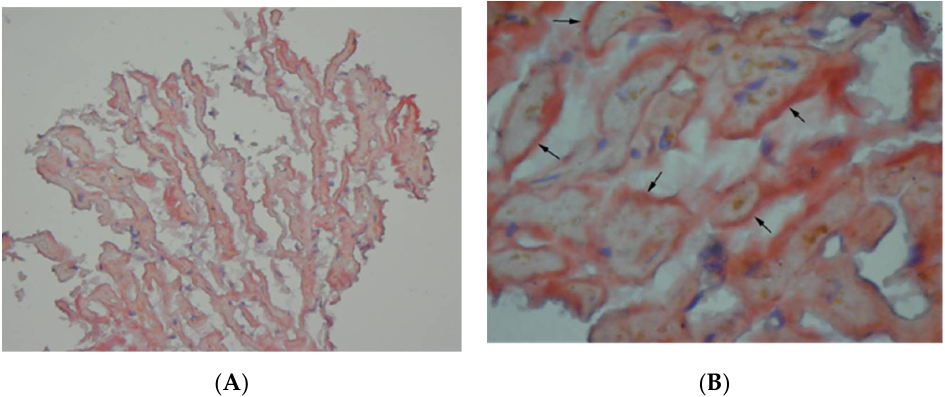
Figure 3. ( A ); Amyloid deposits and ( B ) amyloid deposits (arrows): red material in the section of myocardial biopsy stained with Congo red.